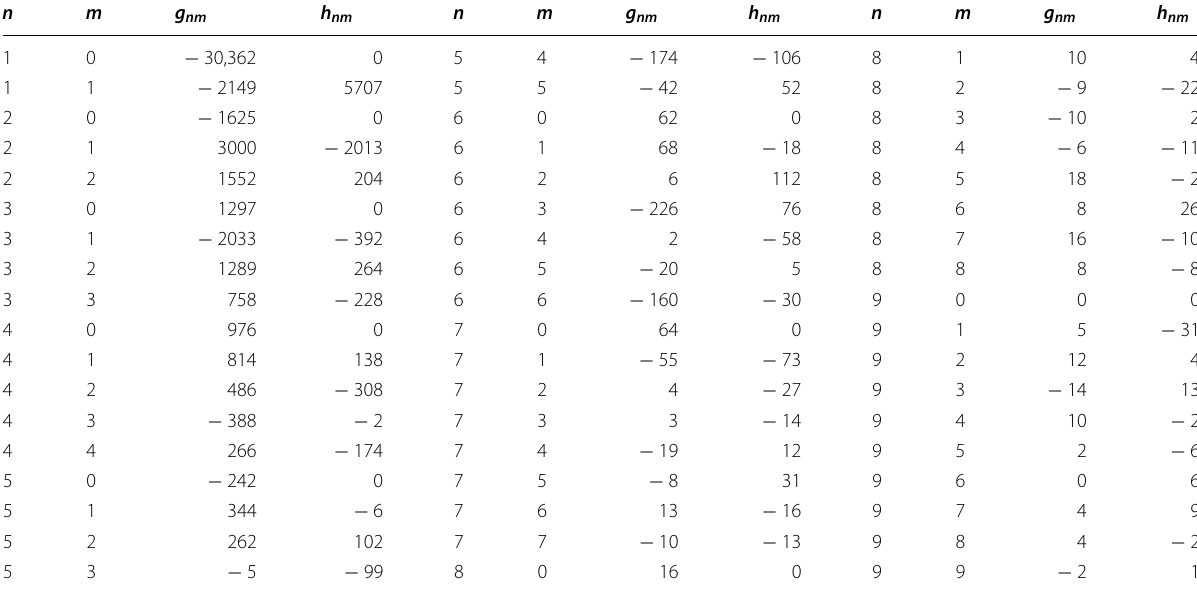
Table 5 Gauss coefficients of the geomagnetic field model at 1964.0 epoch (M-1) based on the measurements from the Kosmos-49 satellite (Dolginov et al. 1967) (the coefficients are listed in three columns)